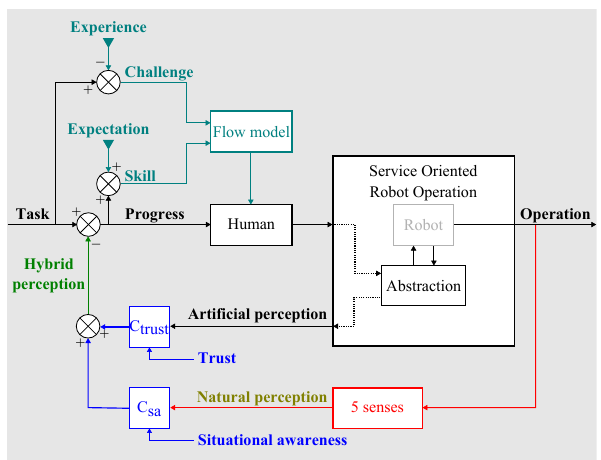
Figure 4: Service Oriented Robot Operation (SORO) concept in the extended HRI